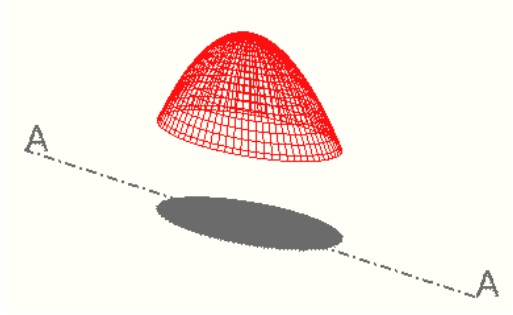
Figure 24: Parabolic load distribution along both directions of a wheel with elliptical tire-ground contact area (the A-A vertical sec- tion is taken along the cross-section of the wheel).